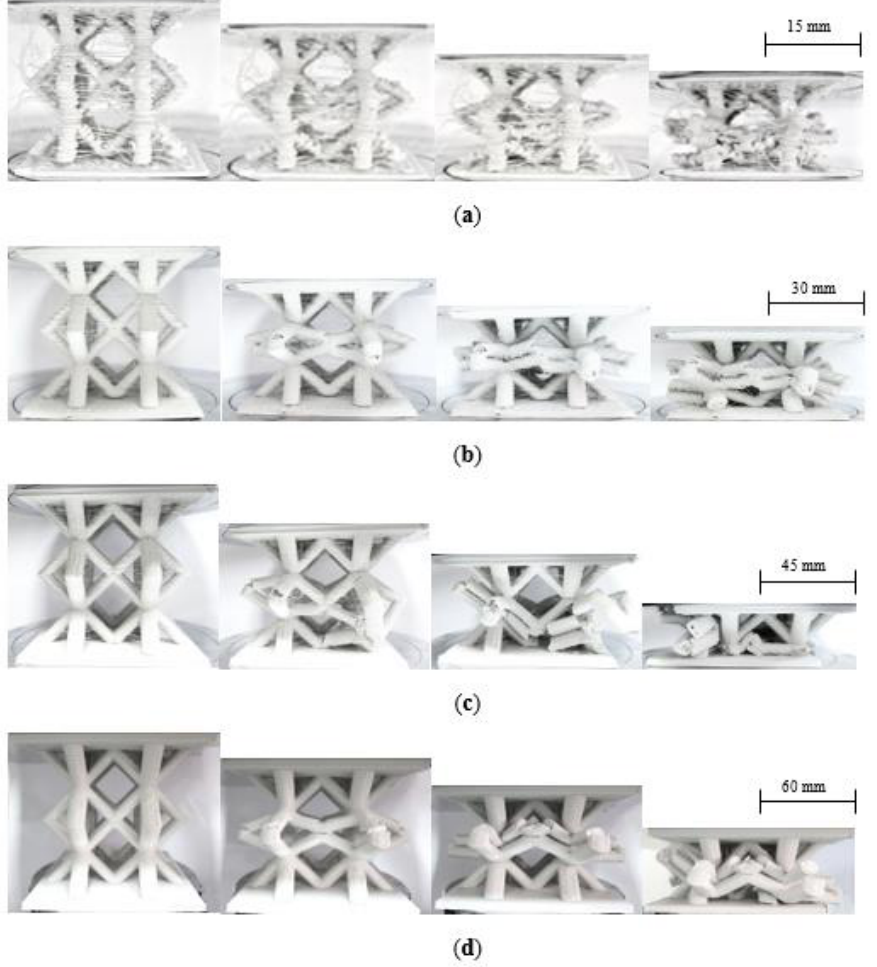
Figure 12. Photographs of the four scaled sizes of lattice structures under compression. ( a ) n = ¼ , ( b ) n = ½ , ( c ) n = ¾ ( d ) n = 1.